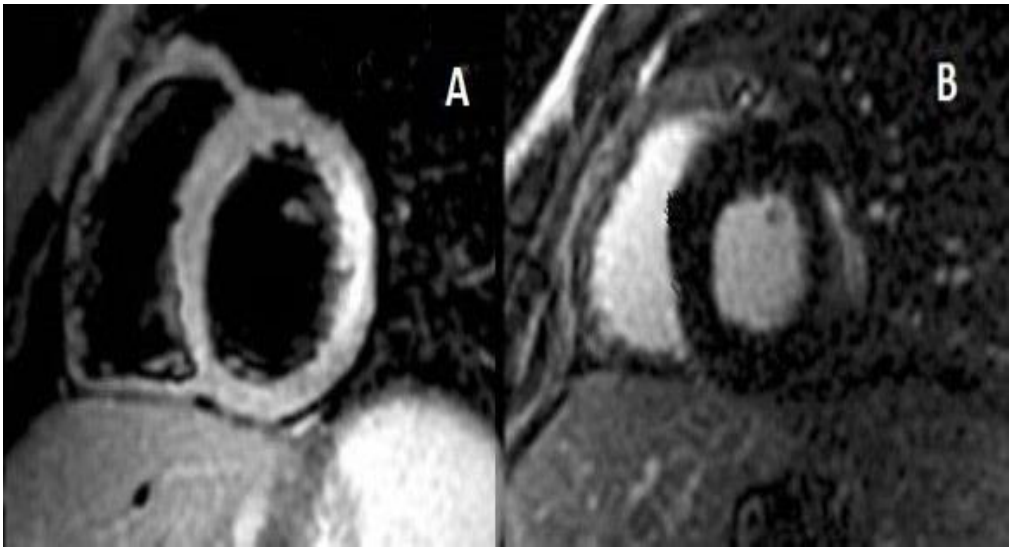
Figure 2. Panel ( A ) Short axis T2-STIR image with lateral hyperintense signal due to myocardial oedema. Panel ( B ) Lateral subepicardial area of late gadolinium enhancement (18% of the left ven- tricle).